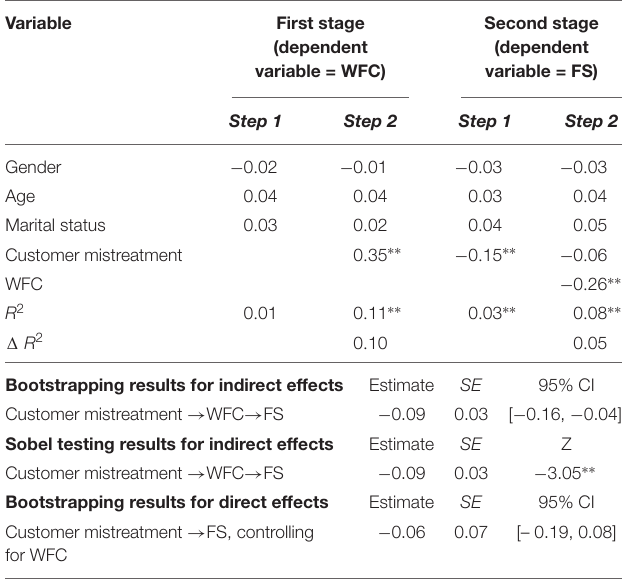
TABLE 3 | Regression results for main effect and mediation effect. TABLE 4 | Result of moderated regression analysis.